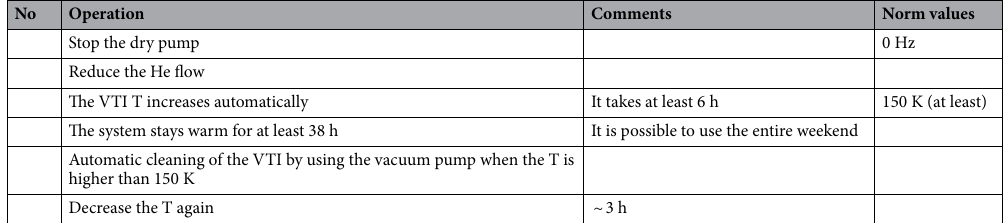
Table 6. dDNP maintenance routine, conducted once a week (automatically and scheduled). The total duration is 48 h from the start of the